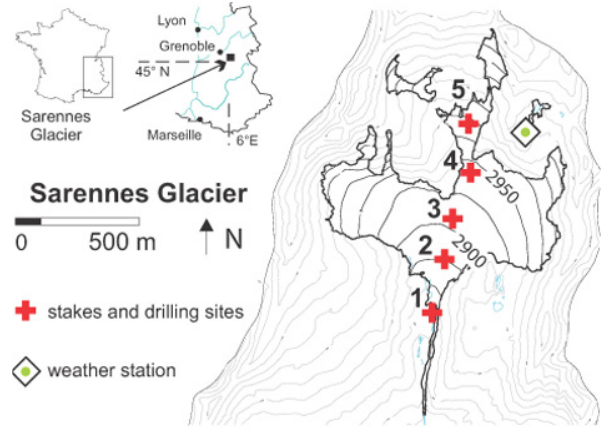
Fig. 1. Location of stakes where balance is measured at Sarennes glacier. Contour lines on the glacier are at 25m intervals.